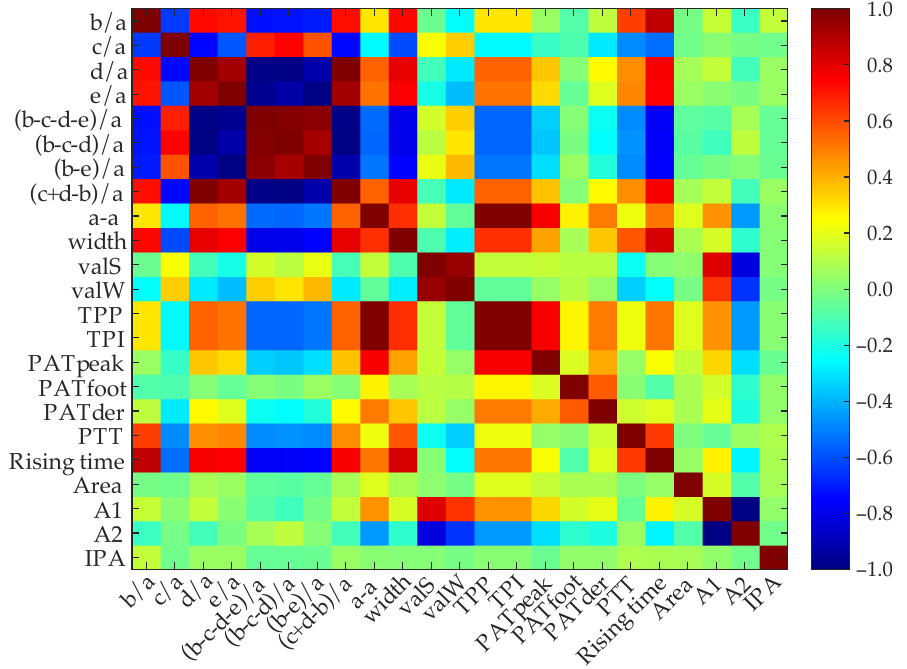
Figure 3. Correlation matrix of the 23 initial discriminatory features used in the study. Dark red values represent higher correlation coefficients and dark blue values represent lower correlation